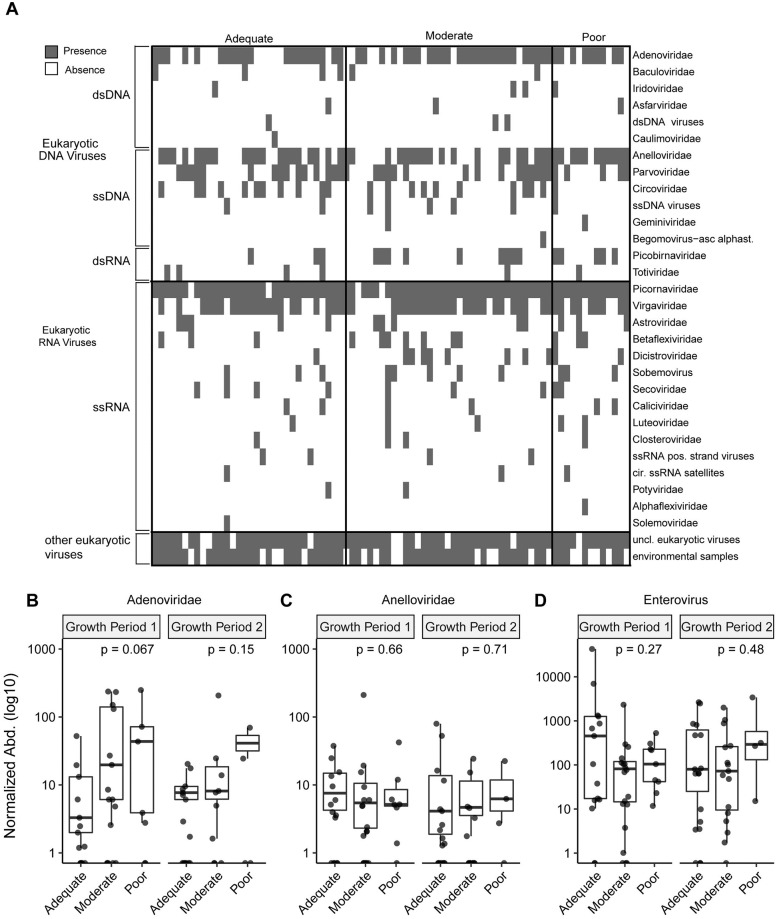
Composition of eukaryotic virome of growth faltering in Evironmental Enteric Dysfunction.A) Presence and absence heatmap of eukaryotic viral families in children with moderate-severe EED grouped by growth velocity status. Normalized abundance of frequently detected eukaryotic viruses in stool samples obtained at the beginning of a growth interval: B) Adenoviridae, C) Anelloviridae, and D) Enterovirus. Statistical significance assessed by Kruskal-Wallis.